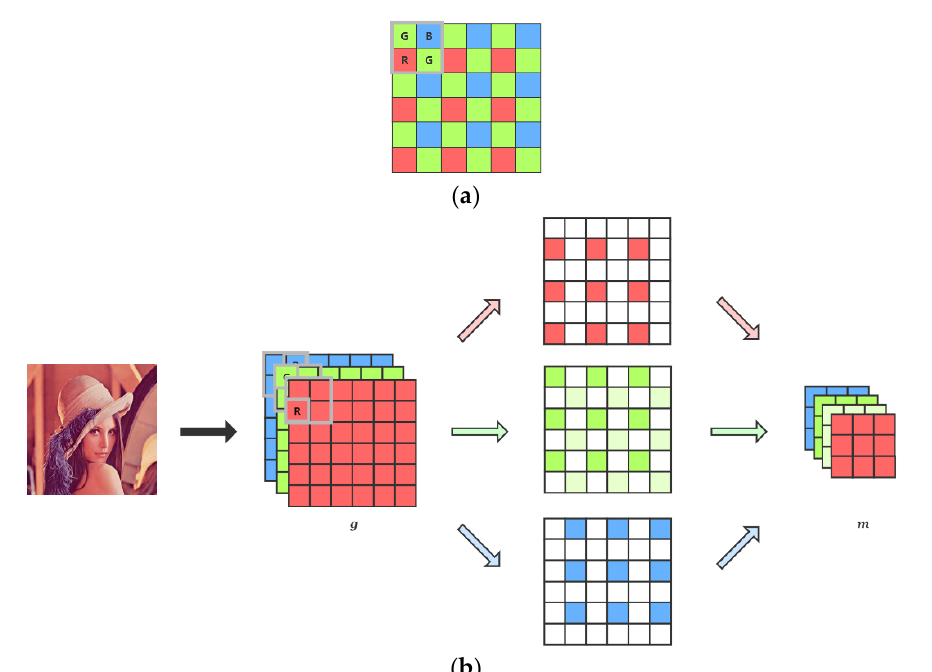
Figure 4. ( a ) The channel (or color) position to be chosen in a 2 × 2 window. ( b ) The process of generating network input from an original RGB image. Note that the two green color of different intensities in the middle of ( b ) both represents the green channel. Just to make the image-generating process more clear and understandable, we painted it to the different green intensities.